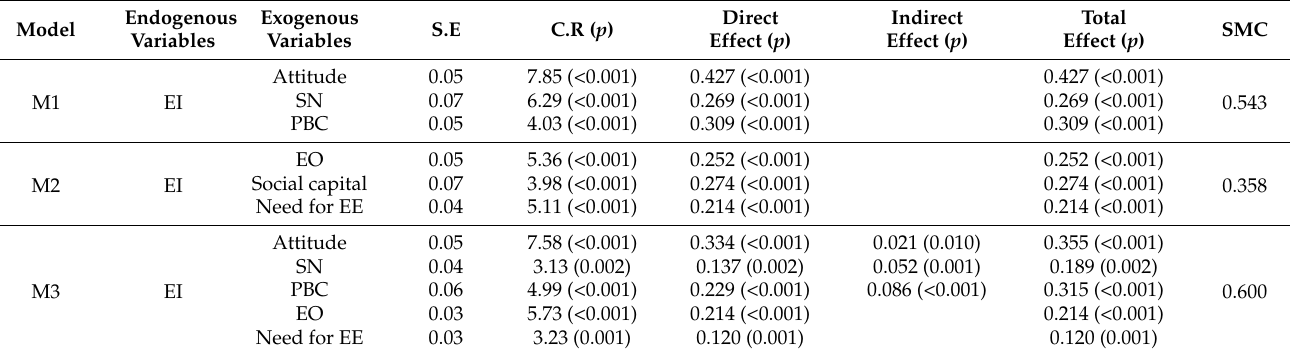
Table 4. Fitness of